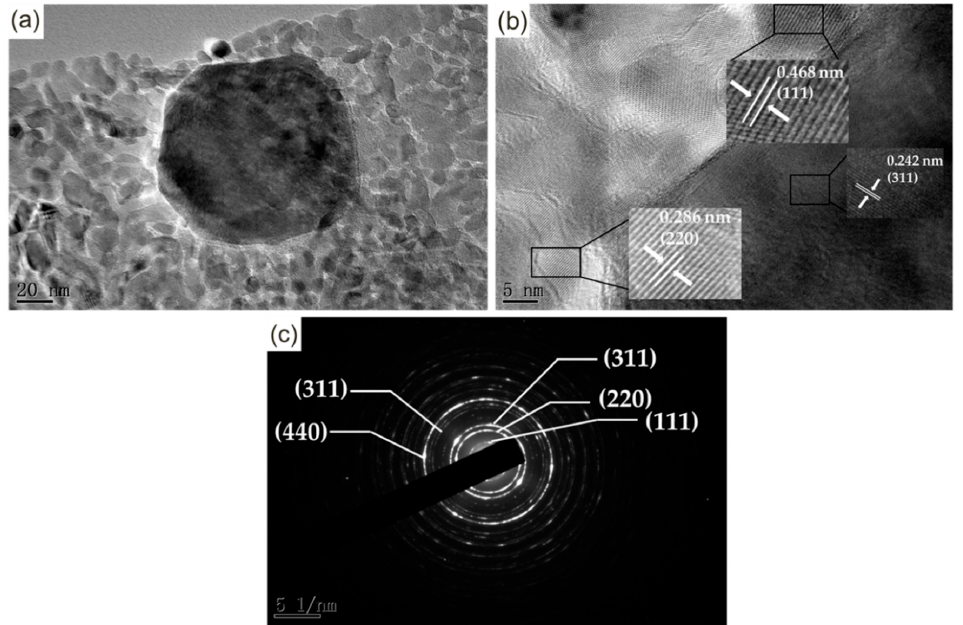
Figure 8. ( a ) Transmission electron microscope (TEM) image; ( b ) Selected area electron diffraction; and ( c ) high-resolution transmission electron microscope (HRTEM) image of the annealed product prepared at a HMT/Co(NO 3 ) 2 mole ratio of